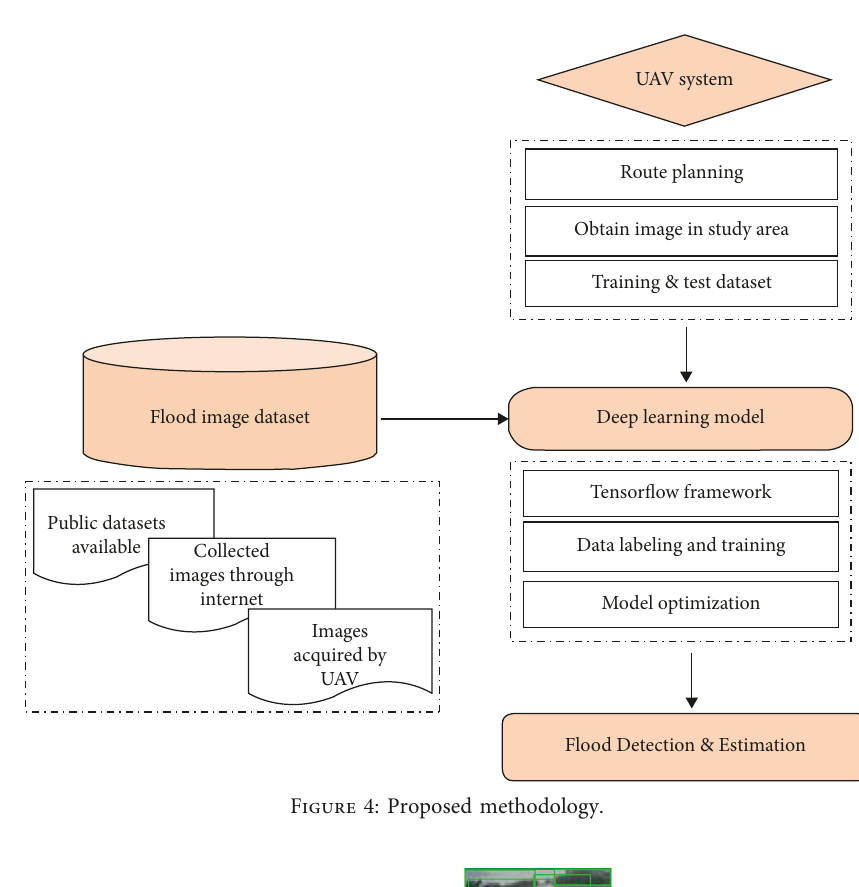
Figure 4: Proposed methodology.